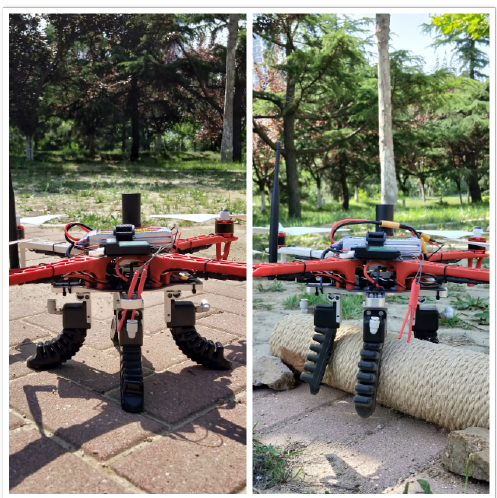
Figure 6. Quadrotor successfully landed on convex surfaces with the support of the proposed soft landing gear.